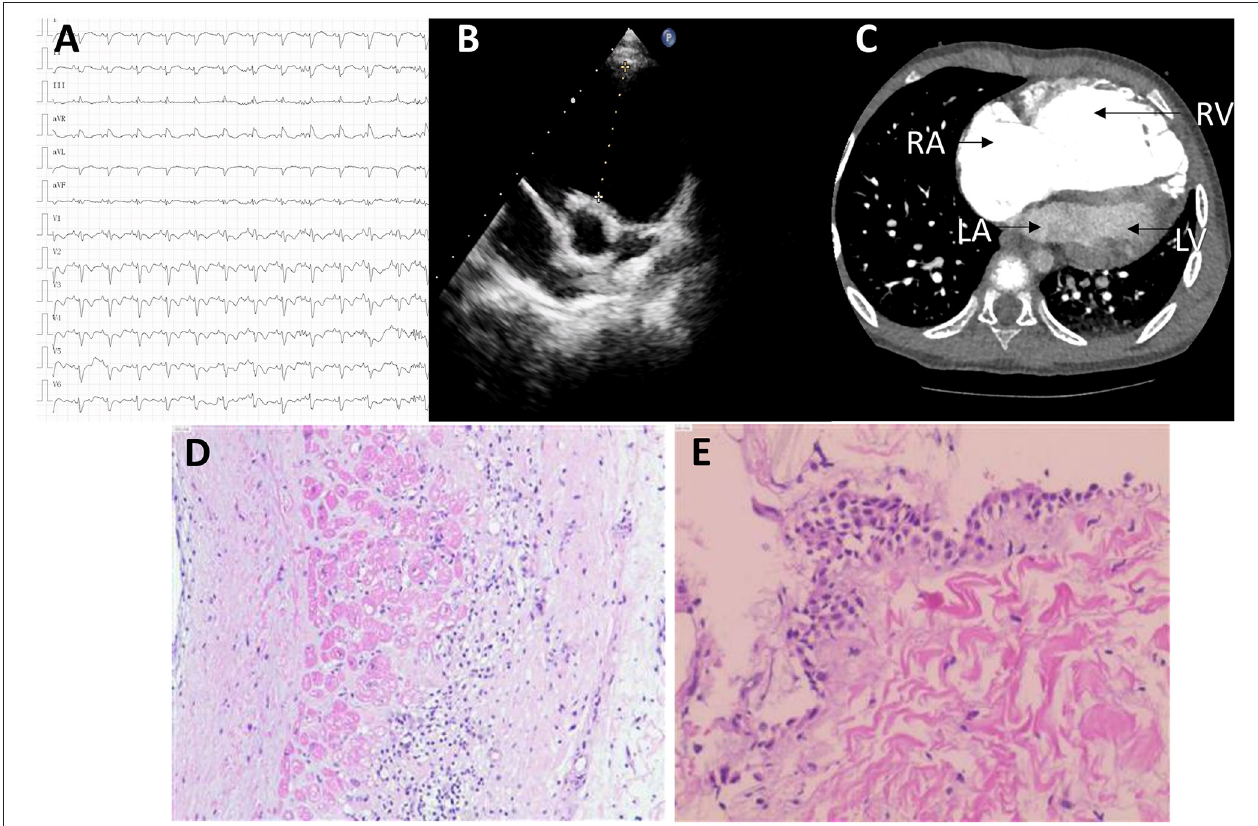
FIGURE 1 | The clinical data. (A) The ECG showing a complete right bundle branch block with T- wave inversion V1–V6. (B,C) The B ultrasonic (B) and CT image (C) showing severe the right atrium (RA), right ventricle (RV), and right ventricle outflow tract (RVOT) dilatation. (D,E) The histopathological results of endocardial and myocardial tissue showing local muscle thinning and fibrous tissue hyperplasia edema. ECG, electrocardiogram; CT, computed tomography; RA, right atrium; RV, right ventricle; RVOT, outflow tract of right ventricle.